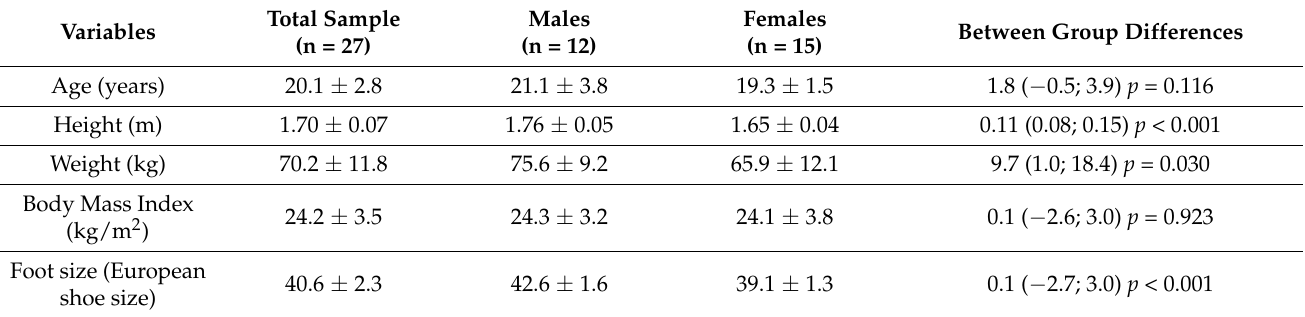
Table 1. Demographic and anthropometric characteristics of the sample.